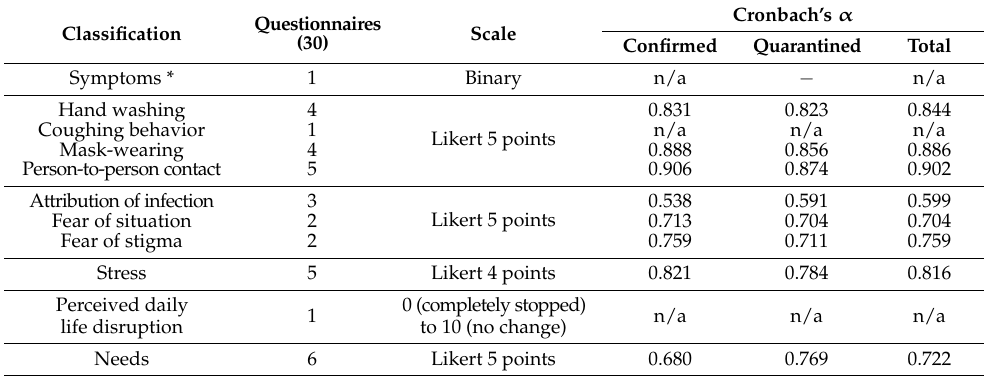
Table 1. Contents of the